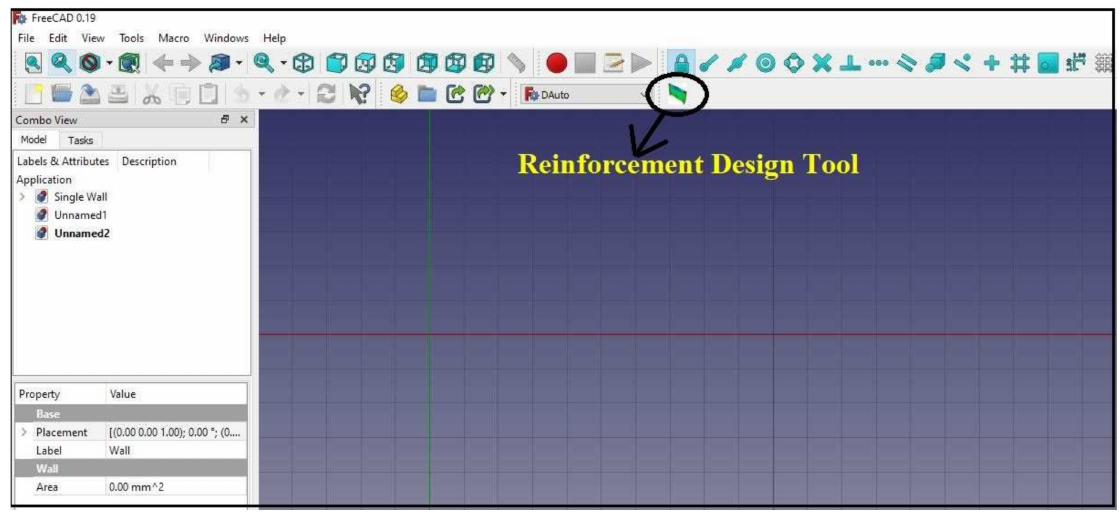
Figure 7. DAuto installed in FreeCAD’s